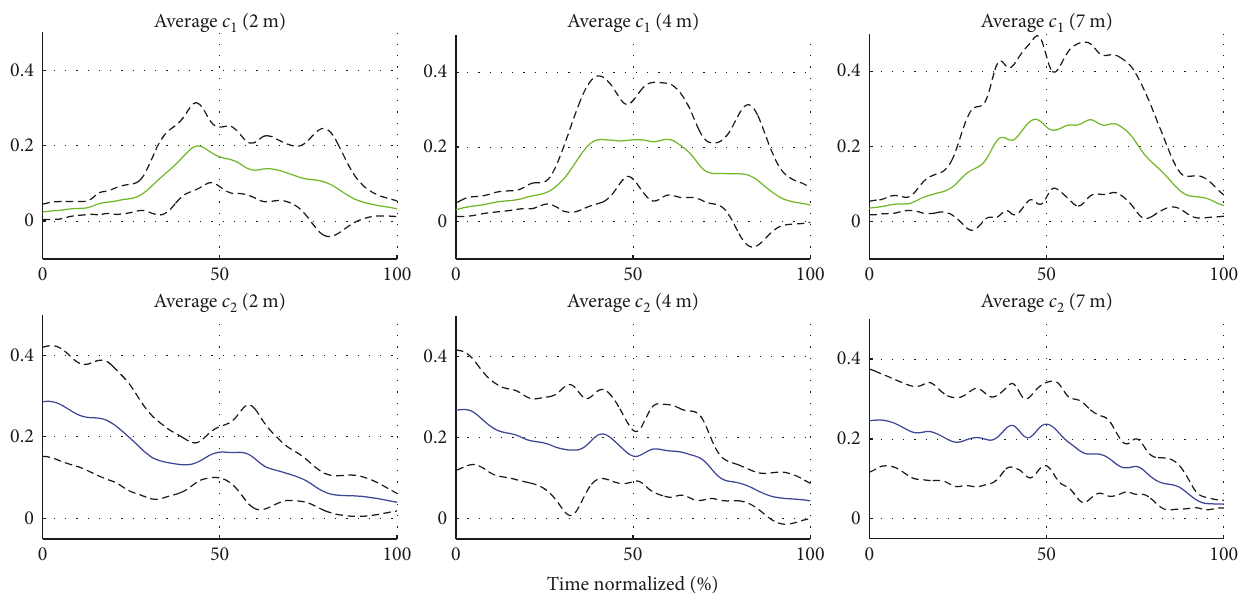
Figure 16: Representative activation space strategy (combination coe ffi cients) C activation space was identi fi ed for the time-variant part of the synergies through method II.